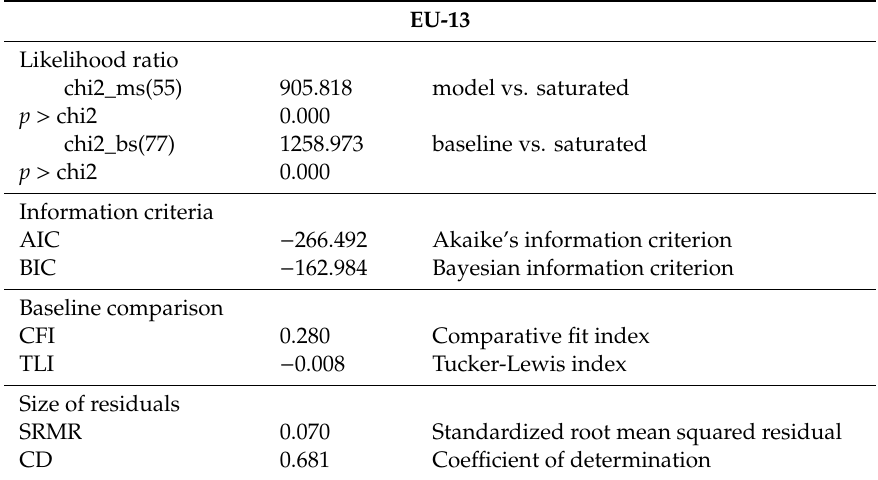
Table A5. Goodness-of-fit tests for the SEM models, EU-13 and EU-15, 1995–2017. EU-13 Likelihood ratio 905.818 model vs.